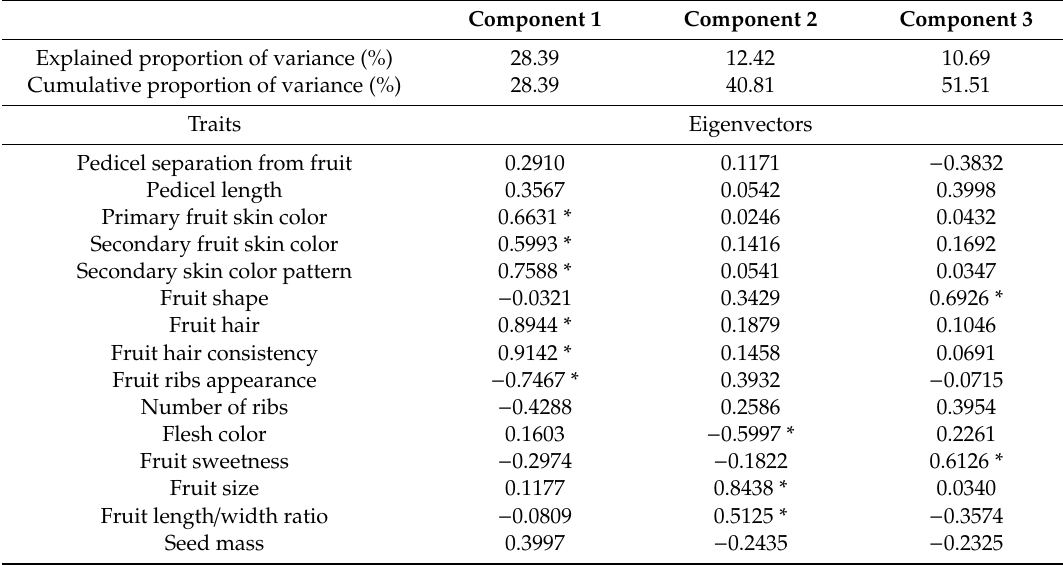
Table 4. Contribution percentages and eigenvectors in the three first principal component analysis (PCA) components analysis of the measured traits for the Lebanese snake melon accessions. Component 1 Component 2 Component